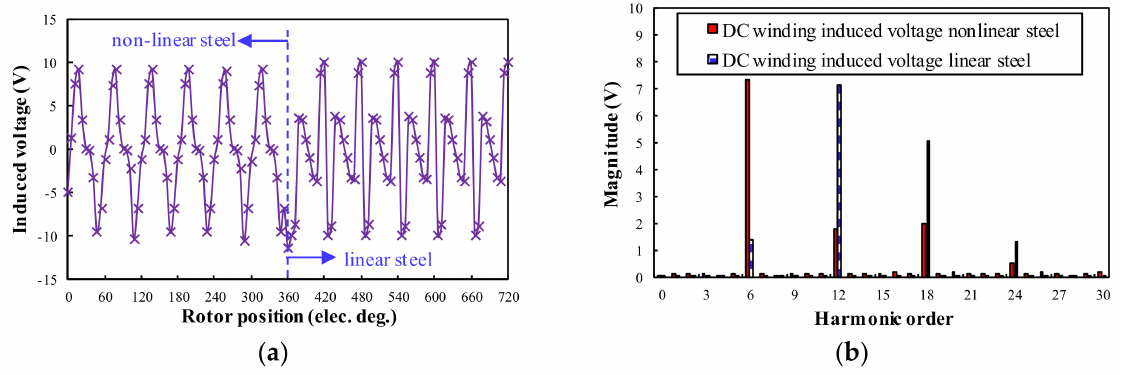
Figure 7. Open-circuit DC winding induced voltage waveforms and spectra for 12/4 WRSM, ( a ) Wave- forms; ( b )